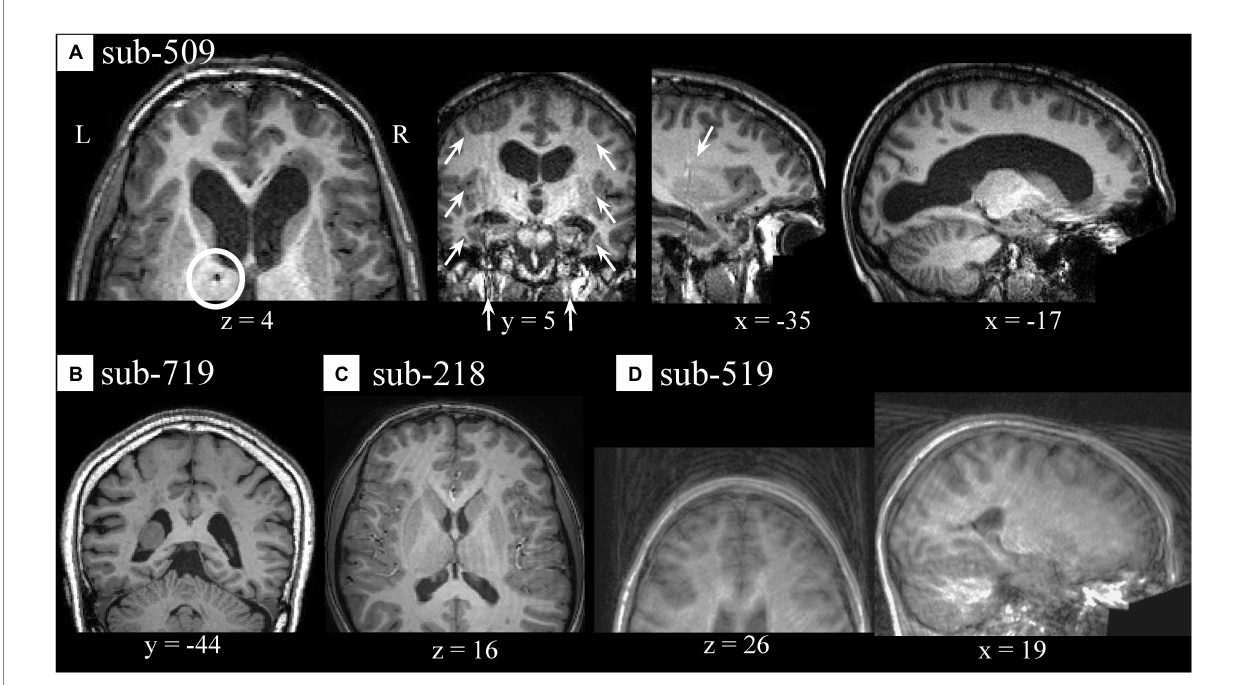
FIGURE 4 Spatial artifacts of anatomical raw-level data. (A) Sub-509 (S88) presented signs of potential past surgery ( z = 4) appearing as dark, small, localized areas traveling through several slices, signal intensity inhomogeneity localized bilaterally along the y -axis ( y = 5 and x = − 35), and individual anatomical variations of size and shape of the lateral ventricles ( x = − 17). (B) Individual anatomical differences in the form of an asymmetrical mass or unspecified signal inhomogeneity localized in the lateral ventricle of a sub-719 (S138). (C) Motion-related artifacts or ringings in sub-218 (S38). (D) Sub-519 (S98) showed severe aliasing, ghosting, and/or motion-related artifacts.